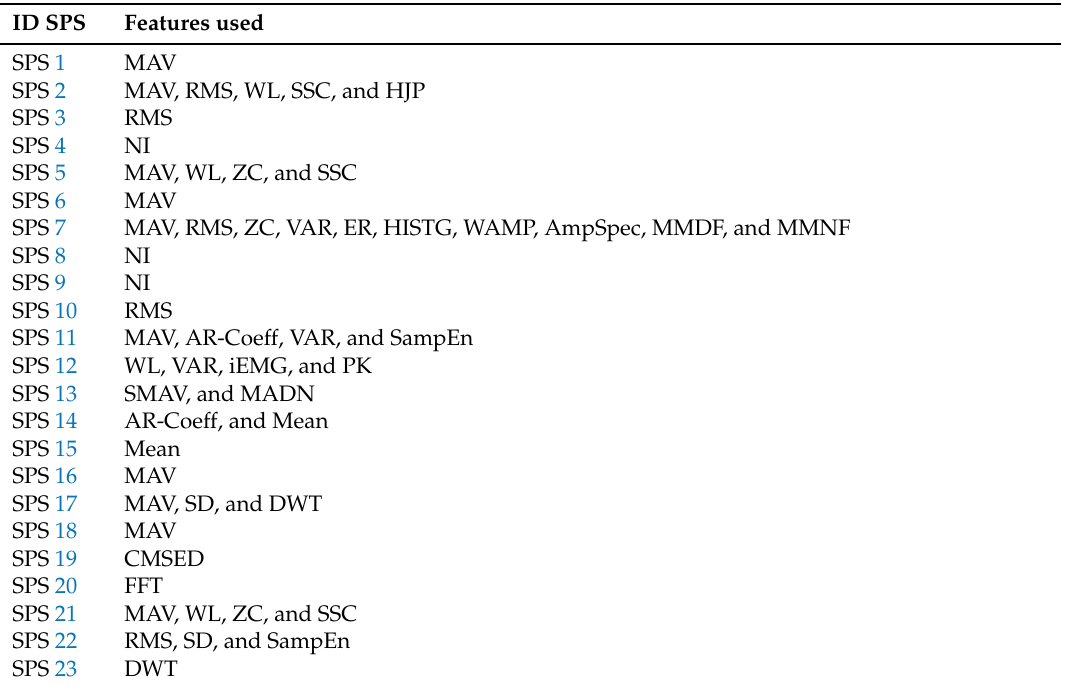
Table 9. Features used in the 65 HGR